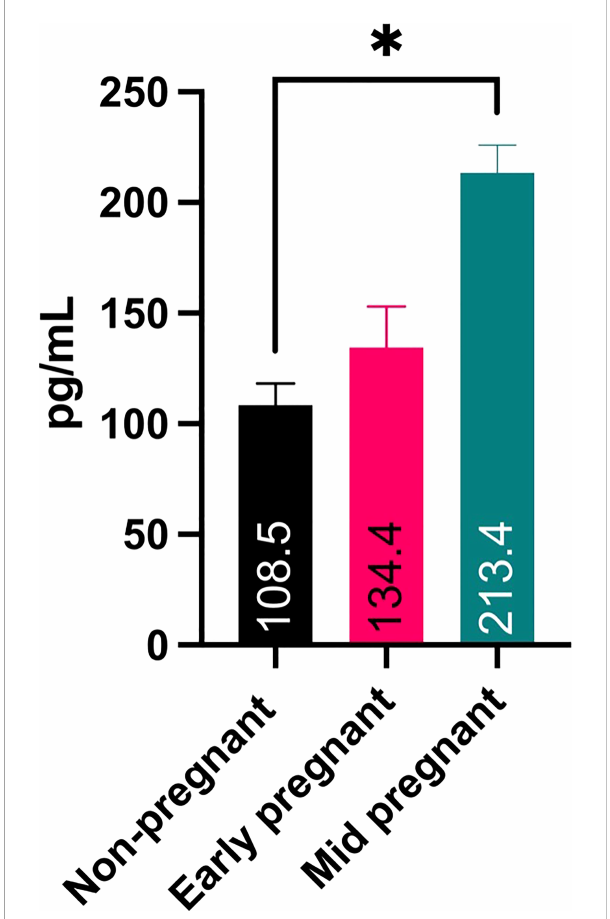
FIGURE 5 ELISA analysis for CRH in maternal serum samples from early- and mid-pregnant and non-pregnant queens. Sample number is 2 for all three stages, and each were run in duplicate. * P ¾ 0.05.